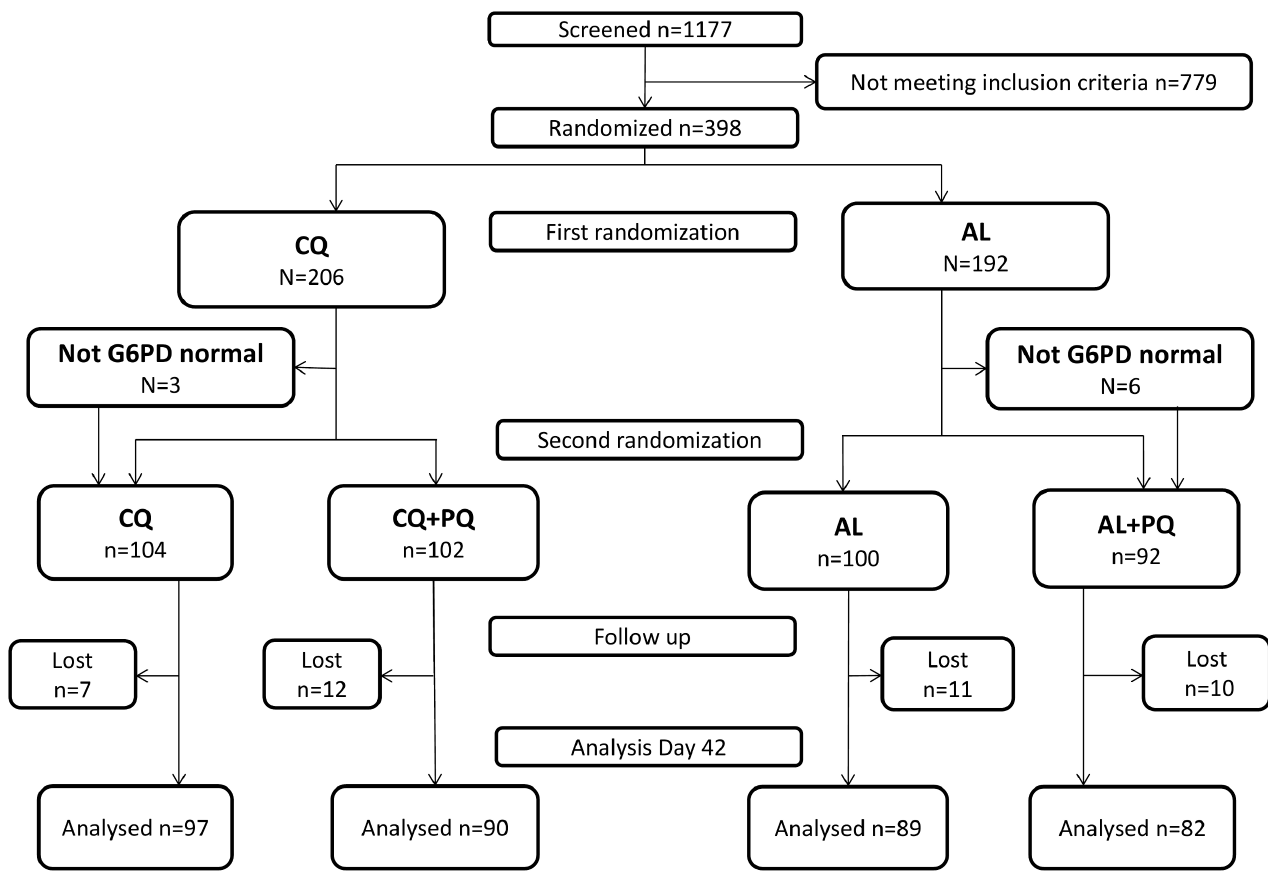
Fig 1. CONSORT flowchart of patient allocation for the day 42 outcome. AL, artemether-lumefantrine; AL+PQ, artemether-lumefantrine + primaquine; CQ, chloroquine; CQ+PQ, chloroquine+ primaquine;G6PD, glucose-6-phosphate dehydrogenase; Lost, lost to follow-up.